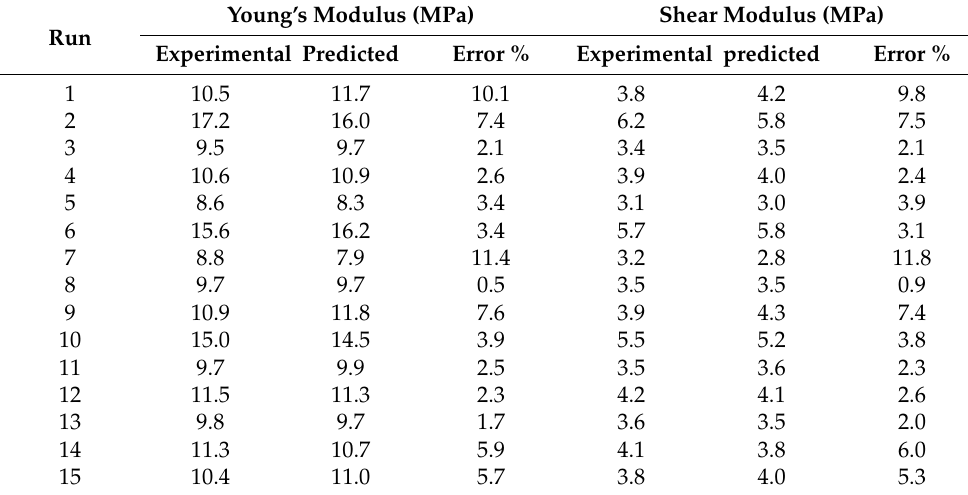
Table 4. Comparison between experimental and predicted values for elastic constants.